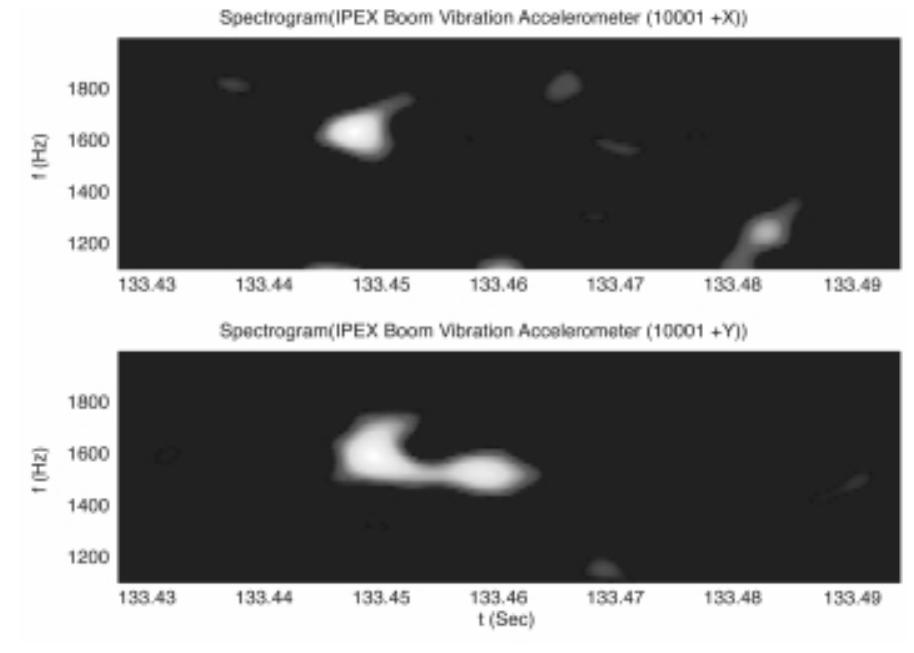
Fig. A6. Event 1 Node 10001 Spectrogram.